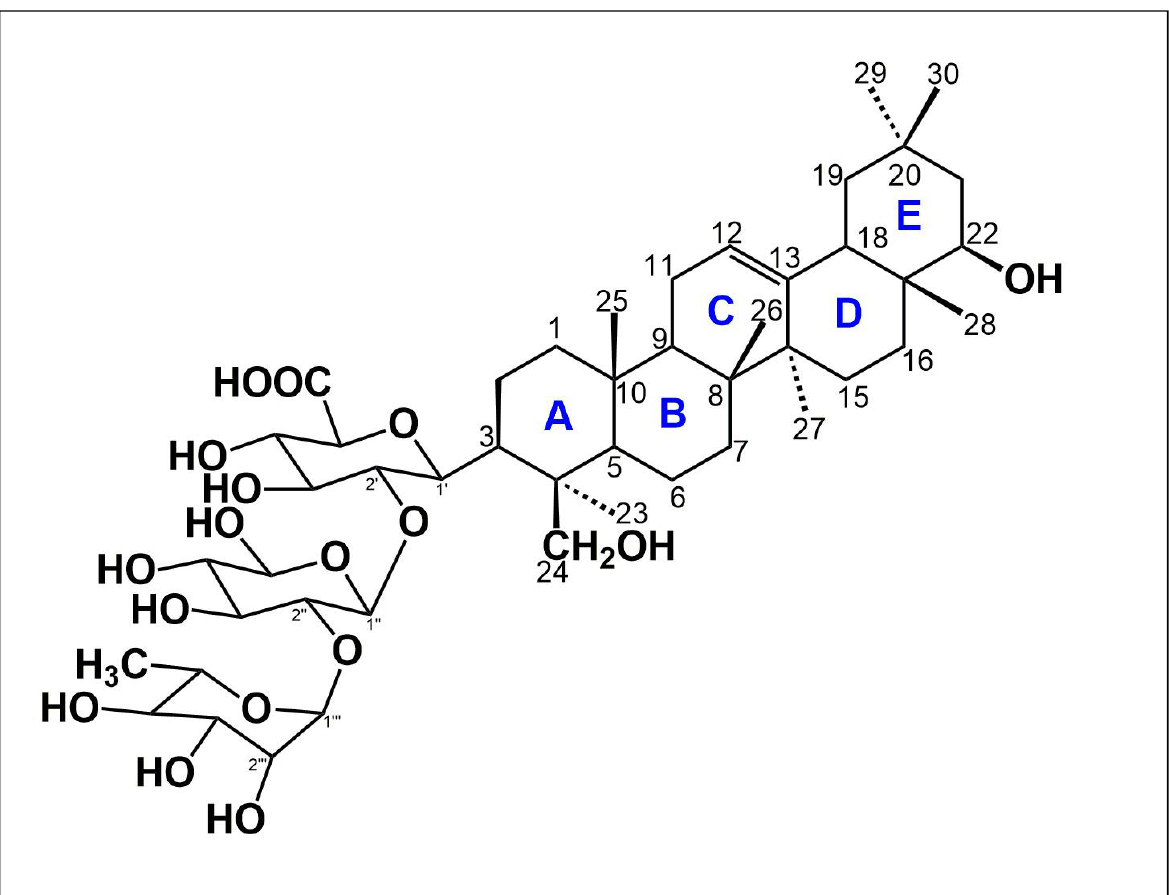
Figure 1: Chemical structure of Soyasaponin